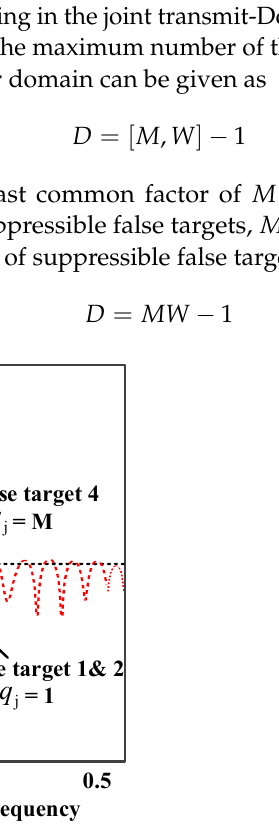
Table 2. Parameters of targets.